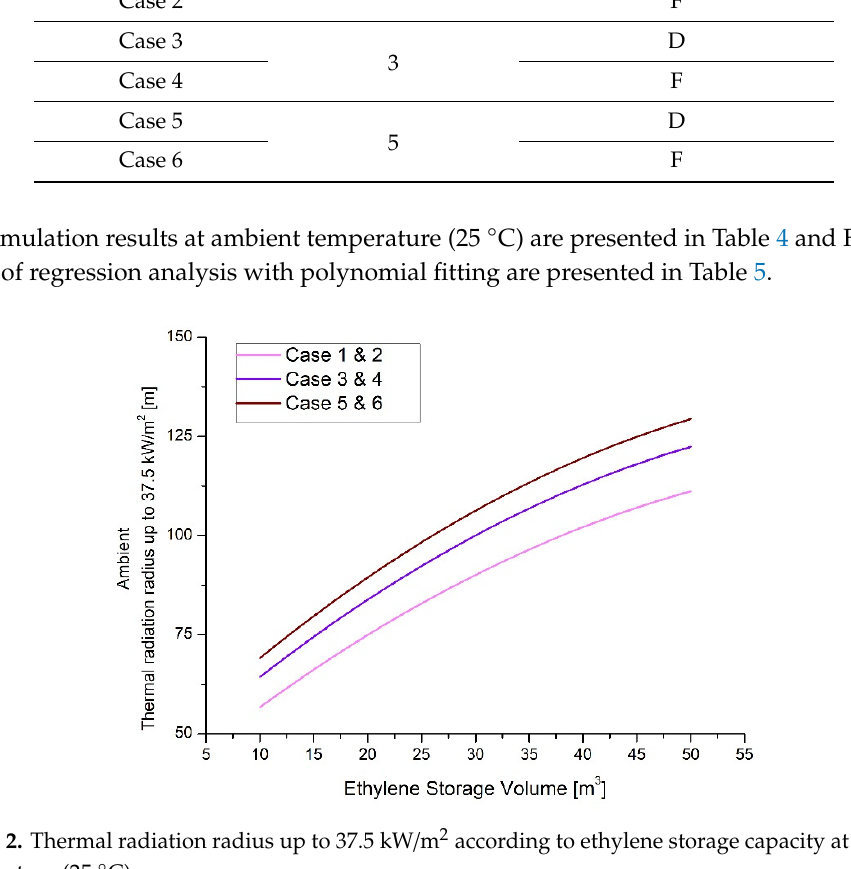
Table 3. Wind speed and atmospheric stability applied to the simulation.